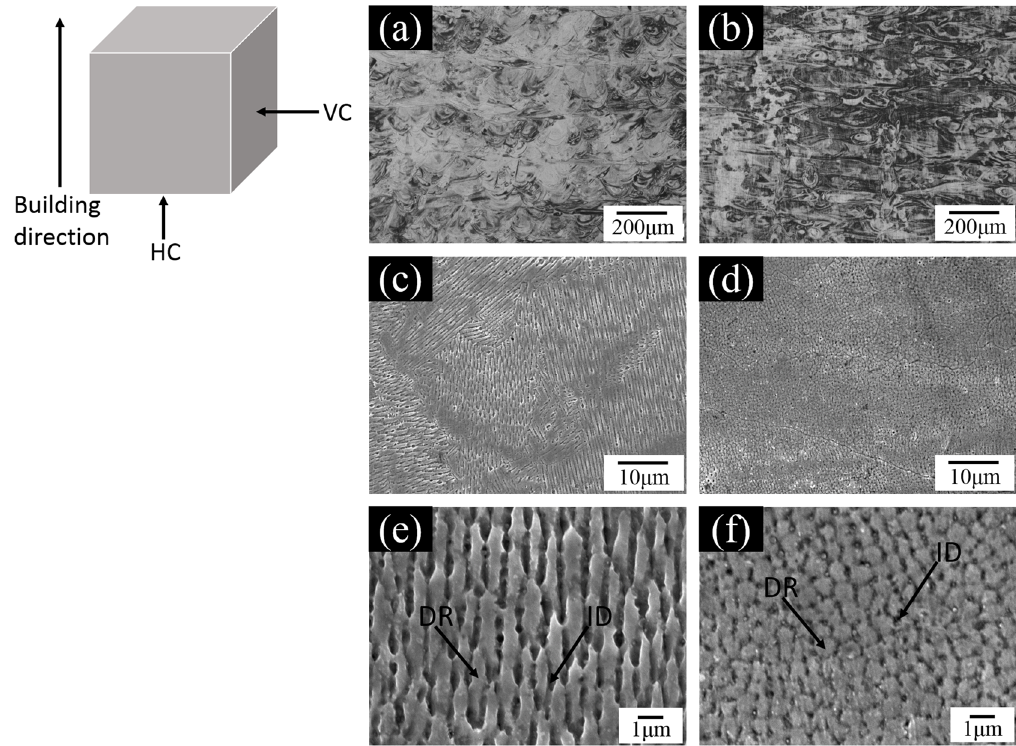
Figure 10. The micrographs of the specimens fabricated by SLM with the optimized parameters: the vertical cross (VC) sections ( a ), ( c ), and ( e ) and the horizontal cross (HC) sections ( b ), ( d ), and ( f ). Table 3. Chemical composition of the SLM specimens (at.%).